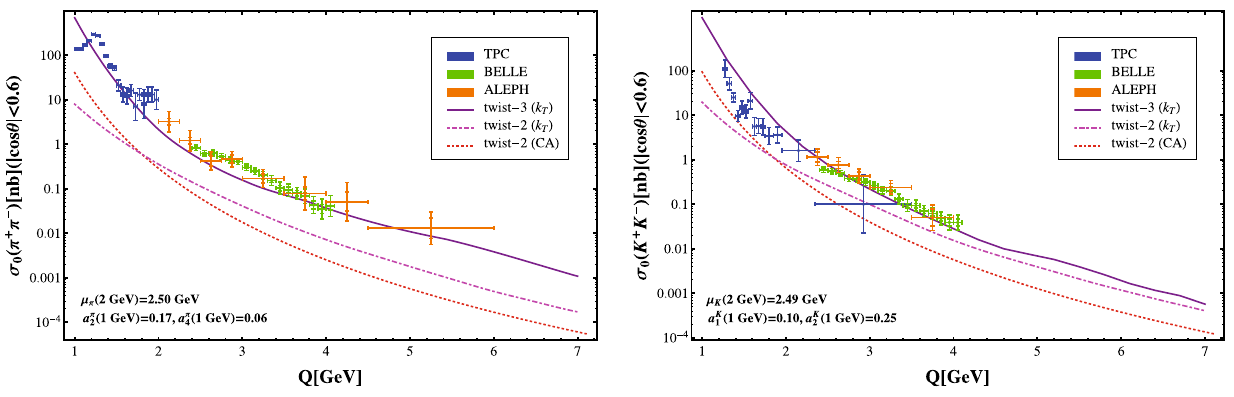
Fig. 5 Cross sections for γγ → π + π − and γγ → K + K − . Red dotted lines: the twist-2 results in the collinear factorization; Magenta dot-dashed lines: the twist-2 results in the k T factorization; Purple solid